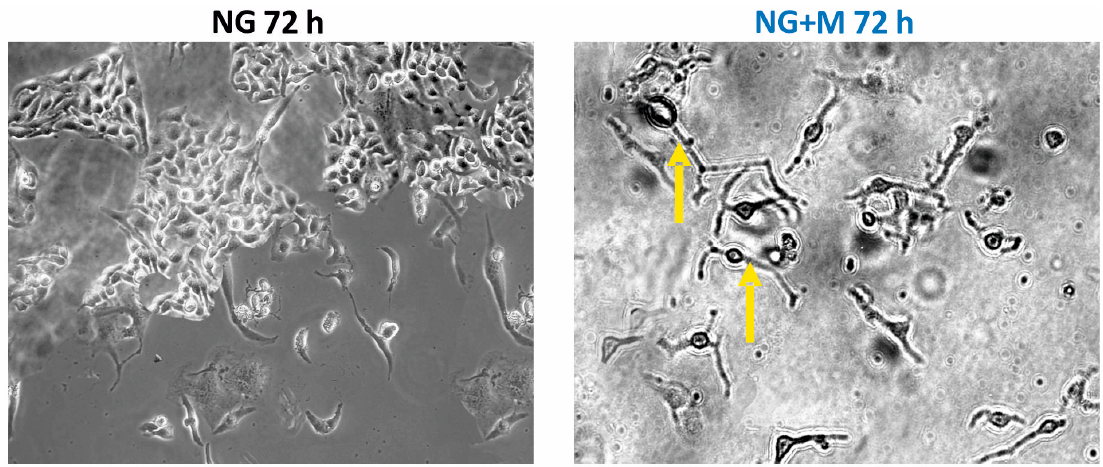
Figure 2. The morphology of SKOV-3 cells treated for 24–72 h with metformin (10 mM) in normal glucose medium examined under an inverted microscope (Olympus IX70, Japan), (scale bar = 100 µ m), elongated, thin cells (yellow arrows).